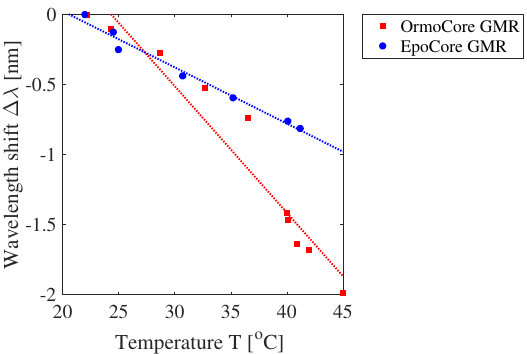
Figure 32. The measured resonant wavelength shift ∆ λ as a function of the temperature T for an OrmoCore and EpoCore GMR grating on polyethylene terephthalate (PET)